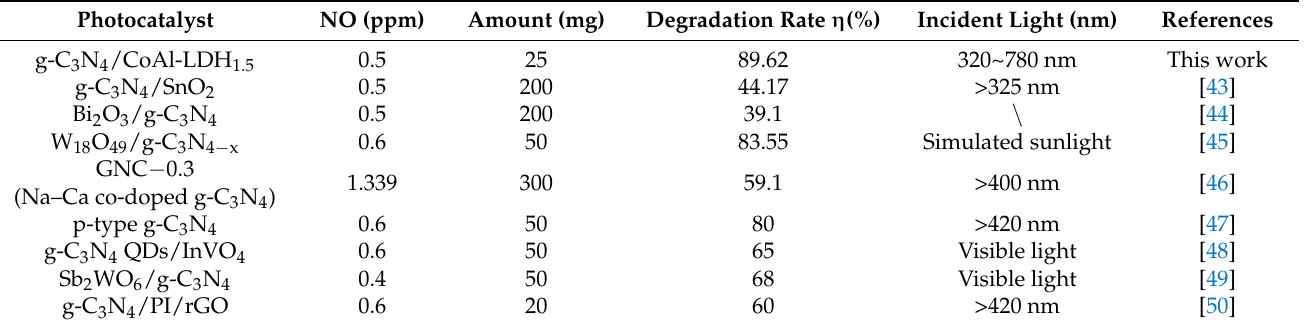
Table 2. Comparison of NO x degradation performances of selected g-C 3 N 4 -based